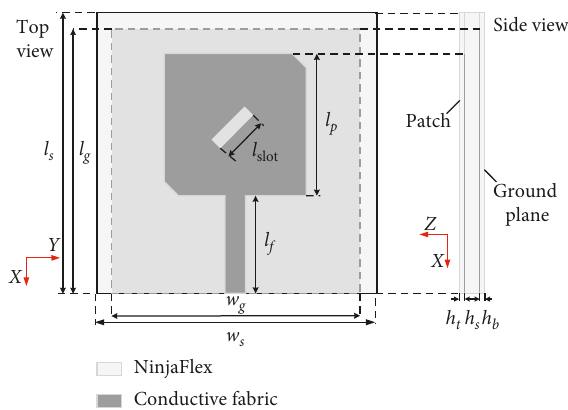
Figure 1: Dimension details of the proposed antenna ( l l